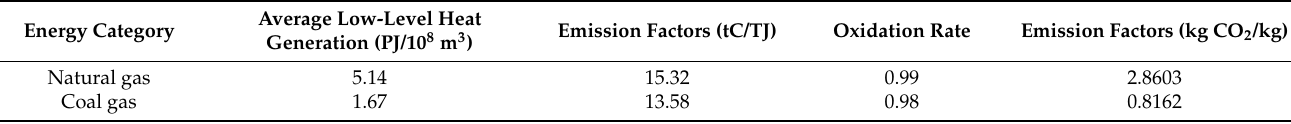
Table 2. Carbon emission coefficients of household energy consumption by energy